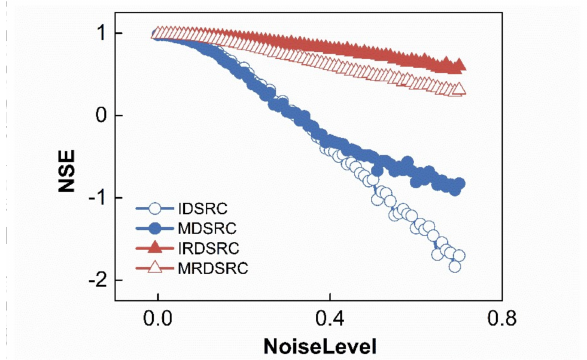
Figure 8. Comparison of four sets of NSE values using different Q obs ( t ) . ‘IDSRC’ represents the updated series with the ideal series obtained by the DSRC method; ‘MDSRC’ represents the updated series with the measured series obtained by the DSRC method; ‘IRDSRC’ represents the updated series with the ideal series obtained by the RDSRC method; ‘MRDSRC’ represents the updated series with the measured series obtained by the RDSRC